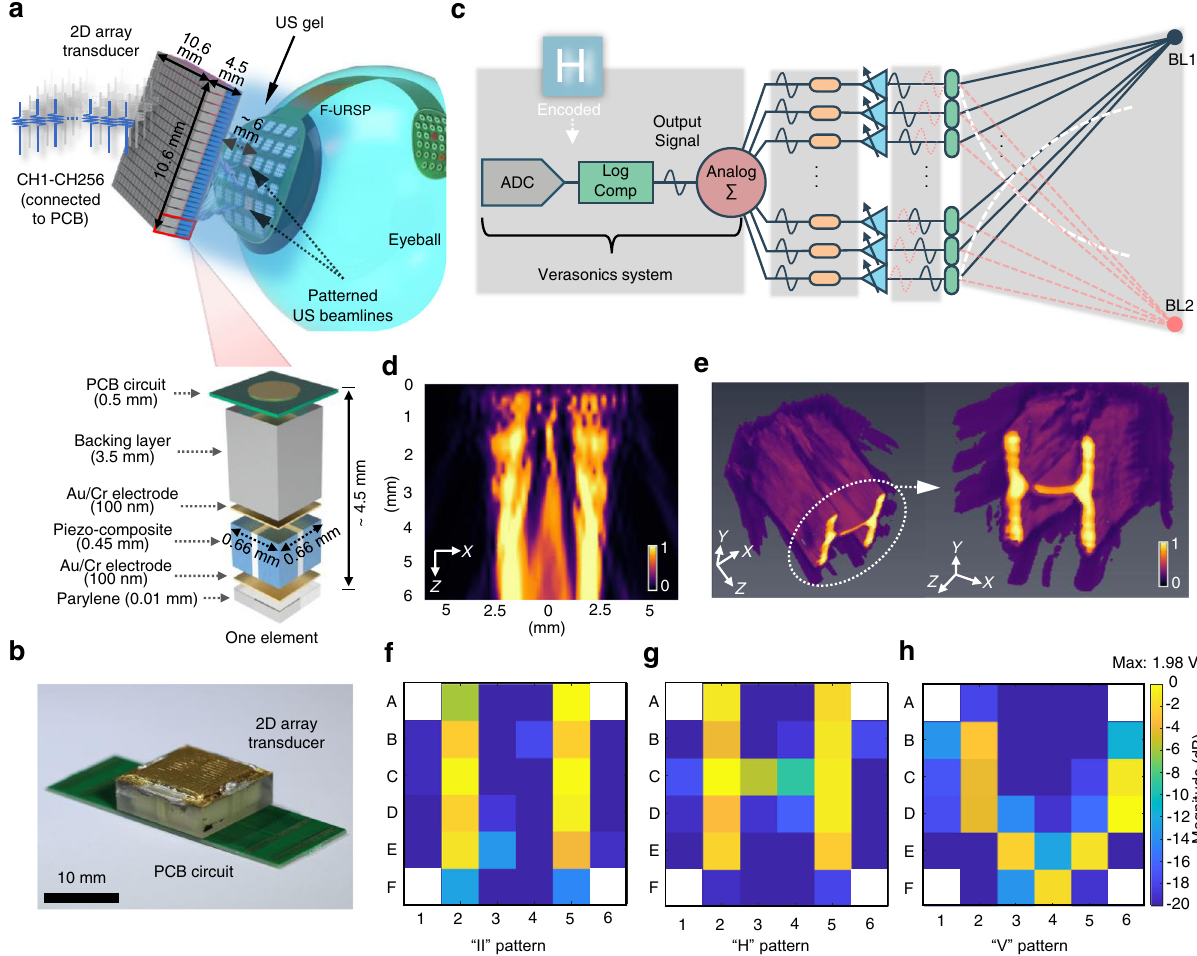
Fig. 5 Recognition function induced by programmable acoustic fi eld of a 2D array transducer. a Schematic diagram showing one working model of the F- URSP, in which a 2D-array US probe was used to excite programmable acoustic fi elds, with key components and aspect ratios labeled. b Photographs of a 2D array transducer. c Schematic diagram showing the US beam steering and focusing with a transducer array by modifying the transmitting amplitude and phase of each element. d Simulated pressure magnitude distribution at the X – Z plane of a “ H ” pattern. e Simulated 3D acoustic intensity distribution of a “ H ” pattern emitted by a 2D array transducer. The color bar ( d , e ) indicates the normalized acoustic pressure. The maximum value is 0.5 MPa. f – h Voltage magnitude distribution imaging results, which were reconstructed via programmable II-shaped ( f ), H-shaped ( g ), and V-shaped ( h ) acoustic fi eld patterns generated by a 2D US array transducer. The maximum output voltage is 1.98 V. The color bar indicates the magnitude distribution (20log V o are provided as a Source data fi